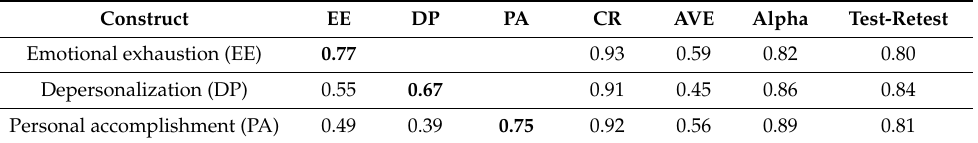
Table 1. Inter-correlation between constructs, composite reliability, average variance extracted, and test-retest results for the Modified